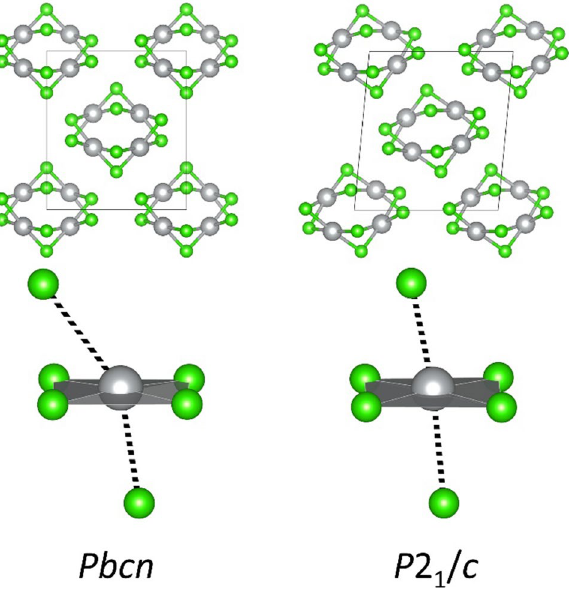
Figure 12. Comparison of structures and local coordination Ag atoms in original and phonon-relaxed structures of HP-AgF 2 -type at 0